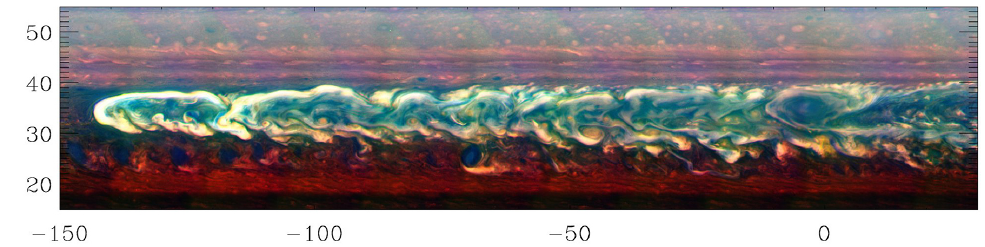
Figure 4. Contrast-enhanced mosaic image of Saturn’s Great White Spot. The images were taken by Cassini ISS (Imaging Science Sub- system) on 6 March 2011. One can clearly see the head of the storm on the left and an anticyclonic vortex in the tail on the right side around 0 eastern longitude. The mosaic covers an area from 15 to 55 ◦ north planetocentric latitude, and a longitude range of 180 ◦ . Image by